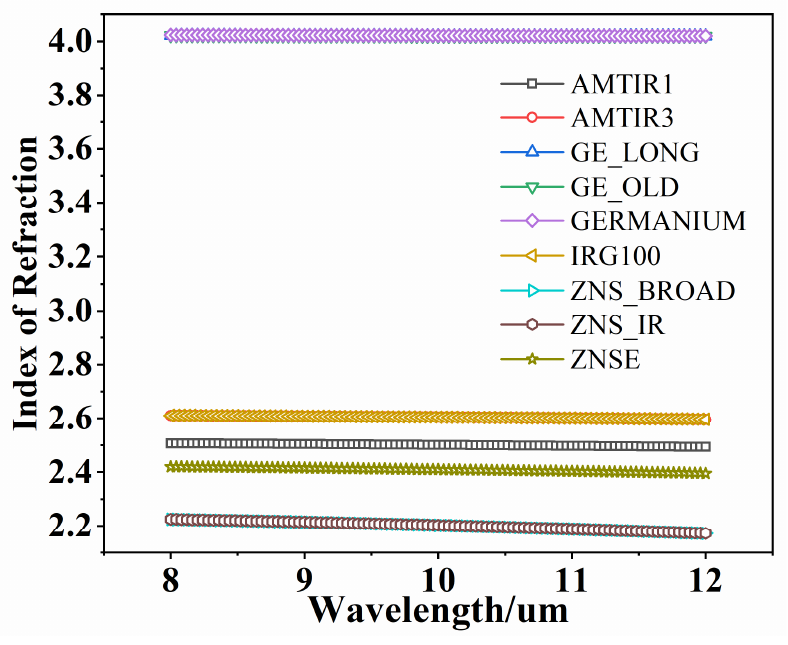
Figure 4. Material selection range and refractive